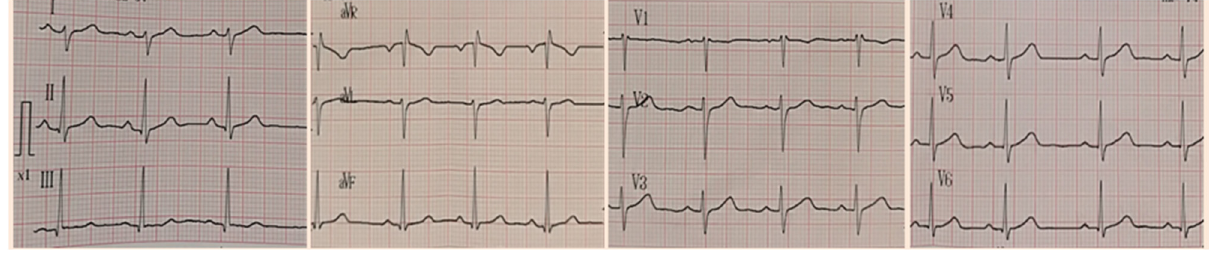
Figure 1. ECG on Day 2.